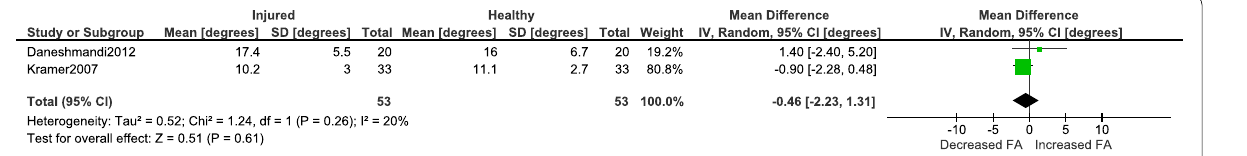
Fig. 4 Meta-analysis results detailing the association between femoral anteversion and ACL